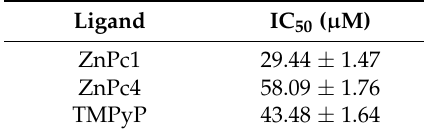
Table 6. IC 50 values of ZnPc1, ZnPc4 and TMPyP in UM-UC3 bladder cells.